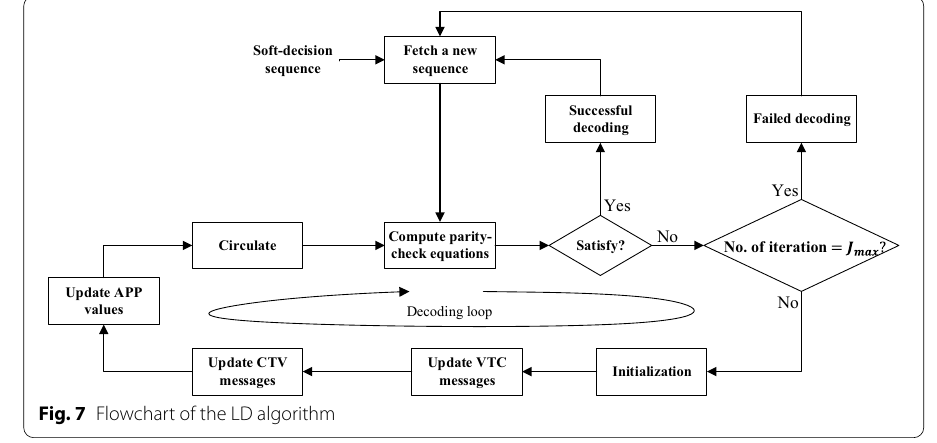
Fig. 7 Flowchart of the LD algorithm